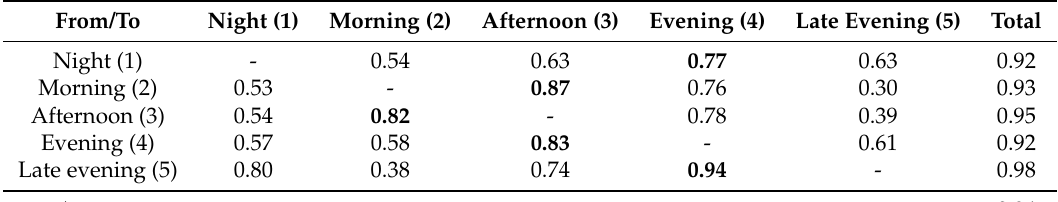
Table 10. Detection rate of the predictor per time slot for NY dataset. The best results per origin time slot are marked in